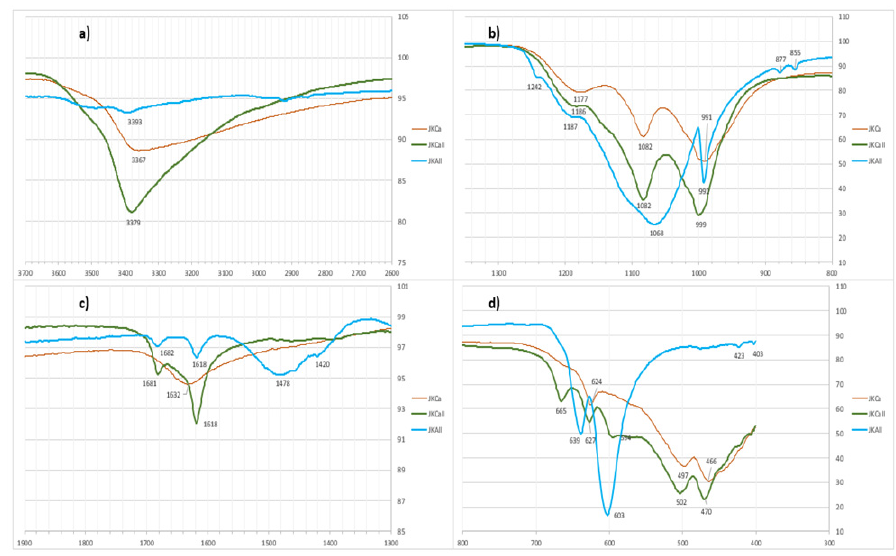
Figure 7. Comparative spectra obtained ( a – d ) for the corresponding doped jarosites obtained.